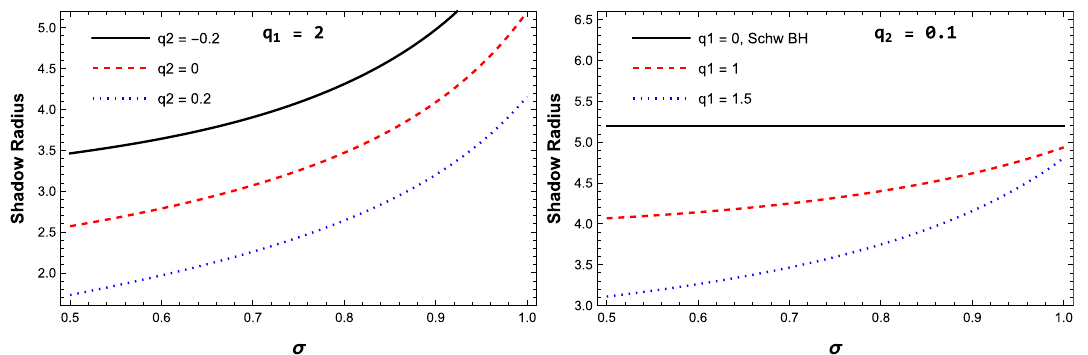
Fig. 8 Variation of shadow radius with increase of the parameter σ , for selected values of q 1 and q 2 . In the left plot q 1 is fixed and q 2 takes three different values while in the right plot, q 2 is fixed and q 1 takes three different values. If q 1 → 0, the radius of BH shadow is the same as with Schwarzschild BH